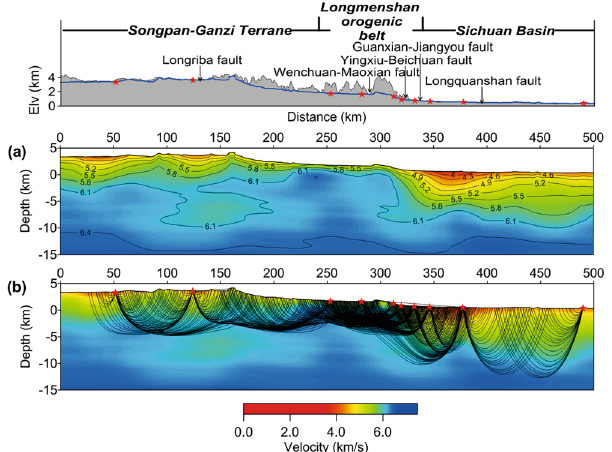
Figure 3. Upper crustal velocity model obtained from first arrival time tomography. ( a ) The velocity model obtained from tomography. ( b ) Ray paths penetrating through the upper crust.